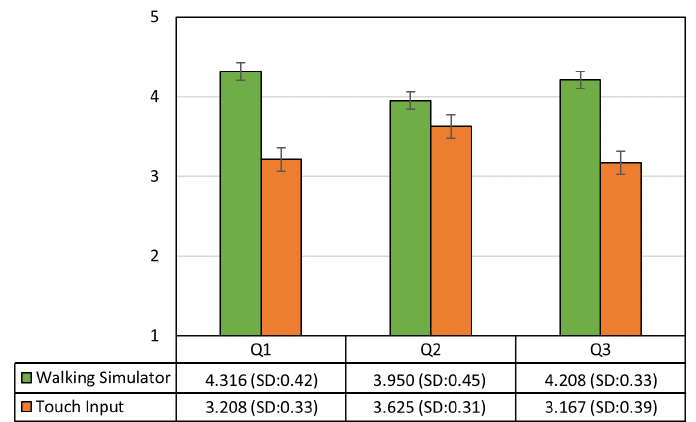
Figure 7. Survey results of the immersive experience of non-HMD users while moving with the walking simulator or touch